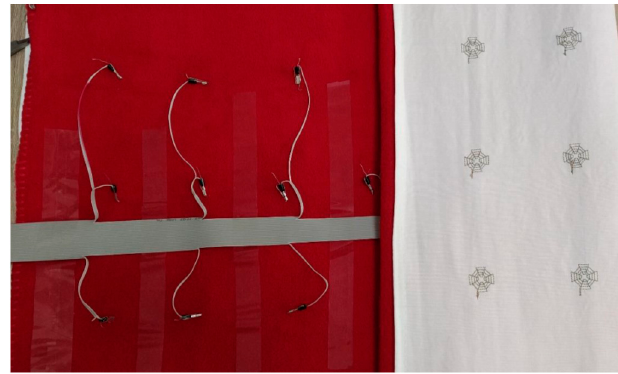
Figure 11. The reverse side of the e ‐ textile mat with the embroidered textile sensors.